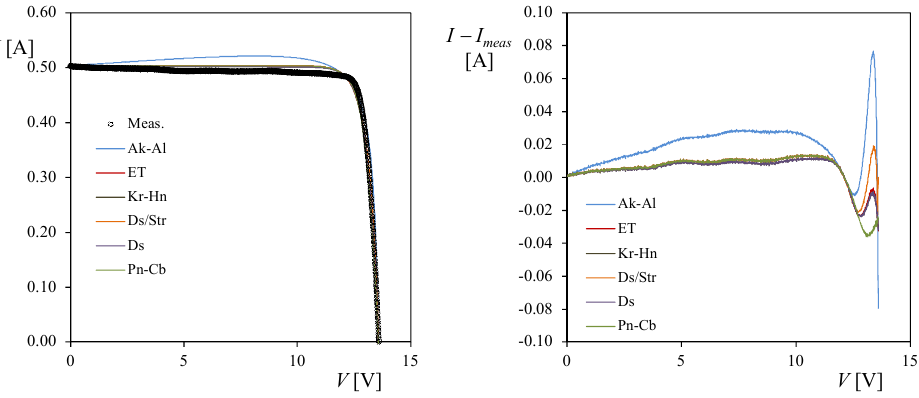
Figure 10. Curves for the explicit models analyzed, fitted to the Selex Galileo SPVSX5 solar cell module data using the analytical methods proposed; see Section 2 ( left ). The error in relation to the data is also included in the figure ( right ).